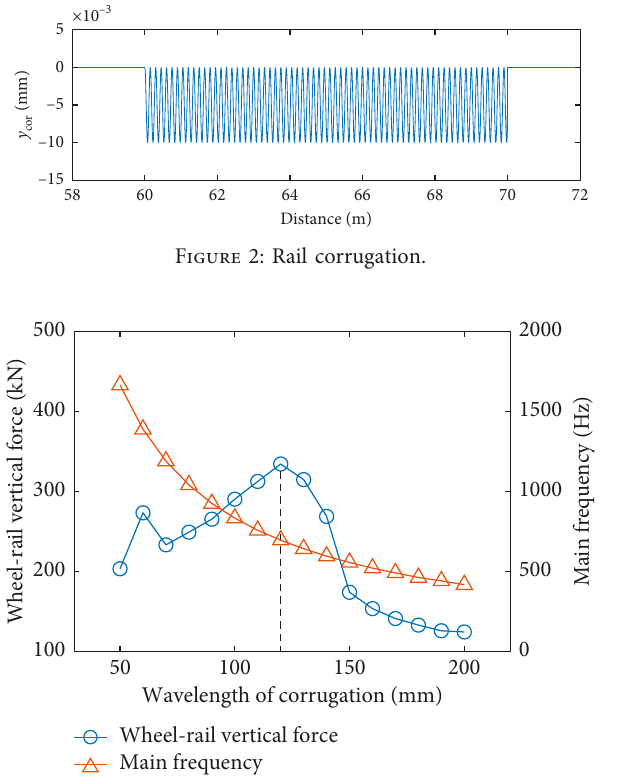
Figure 3: Effect of rail corrugation wavelength on wheel-rail interaction.